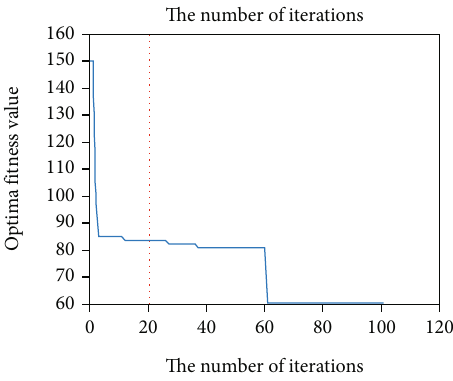
Figure 11: The relationship between the optimal fi tness function and the number of iterations in only ant colony